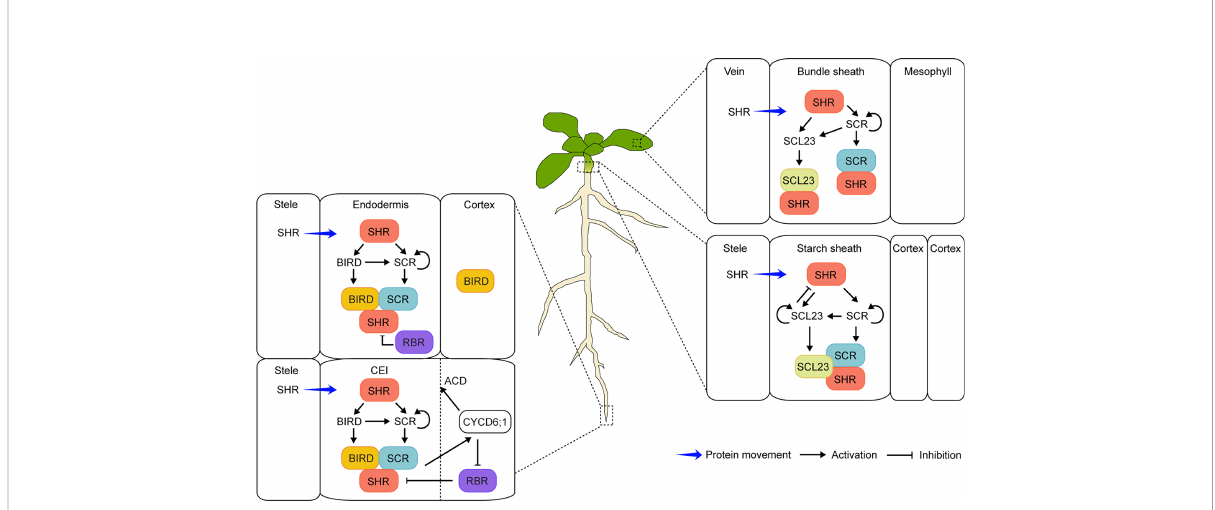
FIGURE 1 Schematic model of the SHR-mediated regulatory networks in the endodermis development of Arabidopsis roots and shoots. In roots (left), SHR protein moves from the stele into the endodermis and CEI (cortex/endodermis initial) where it activates the expression of the downstream target SCR and BIRD genes. SHR forms protein complexes with SCR and BIRD, resulting in the con fi nement of SHR in the endodermis and CEI. The protein complexes induce the CYCD6;1 expression, which subsequently inhibits the negative regulator RBR from interacting with the SHR/ SCR complex and promotes the asymmetric cell division (ACD) of CEI. In leaves and hypocotyls (right), SHR as a mobile regulator activates the expression of both SCR and SCL23 in the endodermis and its equivalents (bundle sheath in leaves and starch sheath in hypocotyls). Protein complexes of SHR-SCR, SHR-SCL23, or SHR-SCR-SCL23 can be formed, which prevents SHR from moving beyond the endodermis. Moreover, SCL23 negatively regulates SHR function in